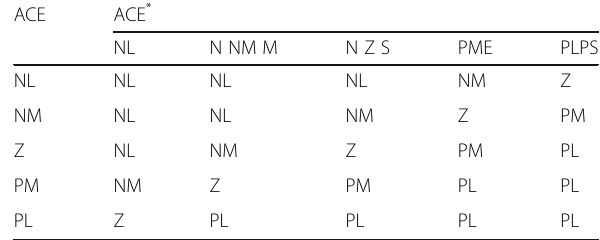
*indicates a change in area control